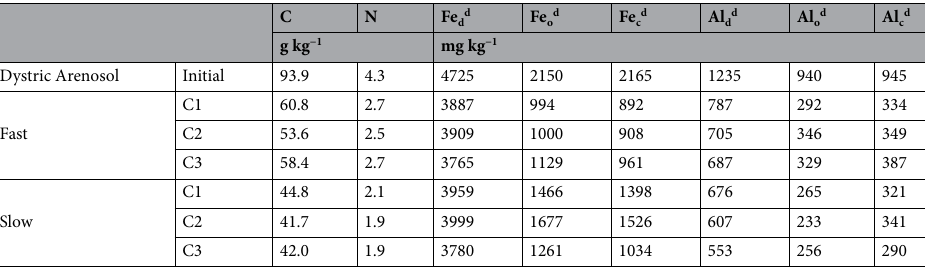
Table 1. Contents of carbon (C), nitrogen (N), and dithionite-, oxalate-, and citrate-extractable Fe and Al (indicated by subscripts d, o, and c) of soil material from the AE horizon of a Dystric Arenosol before (Initial) and after irrigation with acetic acid at q = 10 mm h −1 (Fast) and q = 0.01 mm h −1 (Slow) in triplicate